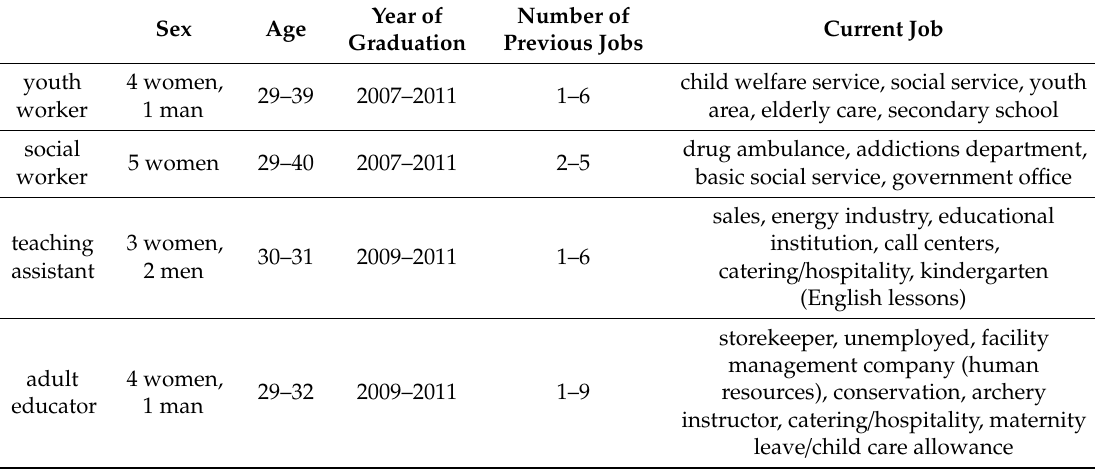
Table 2. Details about the